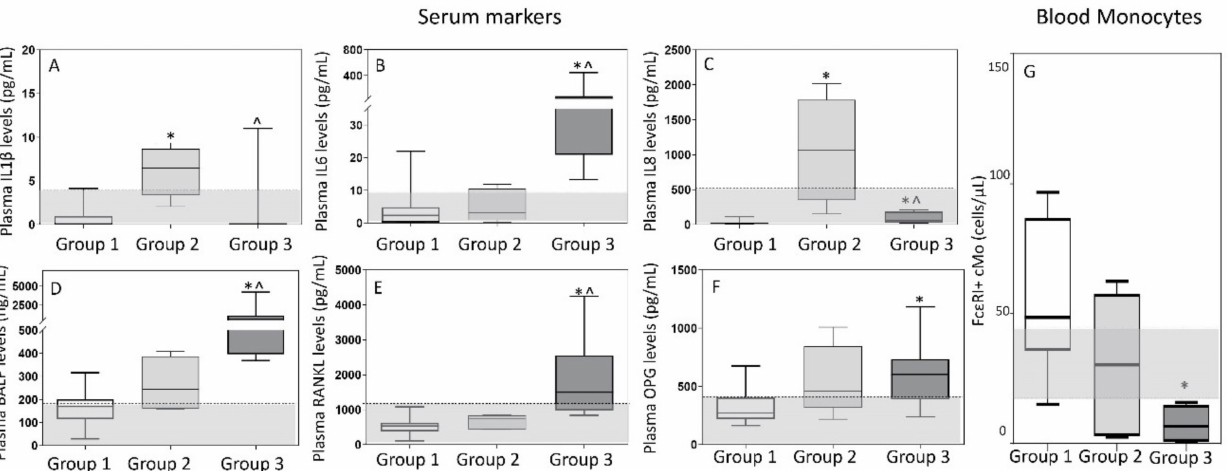
Figure 5. Soluble levels of cytokines (panels A – C ) and bone-associated markers (panels D – F ) in plasma and absolute Fc ε RI + cMo counts in blood (panel G ) of MGUS, SMM, MM and HD classified by multivariate analysis into the T-distributed stochastic neighbor embedding (T-SNE)-defined groups 1, 2 and 3. In (panels A – G ), notched boxes extend from the 25th to the 75th percentile values; the lines in the middle and vertical lines correspond to median values and the 5th and 95th percentiles, respectively. Normal range is represented by a gray area limited by a horizontal black dotted line. Statistical significant differences ( p ≤ 0.05) were observed vs. * group 1 or ˆ group 2 after applying the Mann–Whitney non-parametric test (as the KS normality test showed that data for these variables did not follow a normal distribution). IL: interleukin; BALP: bone alkaline phosphatase; RANKL: receptor activator of the nuclear factor-kB ligand; OPG: osteoprotegerin; cMo: classical